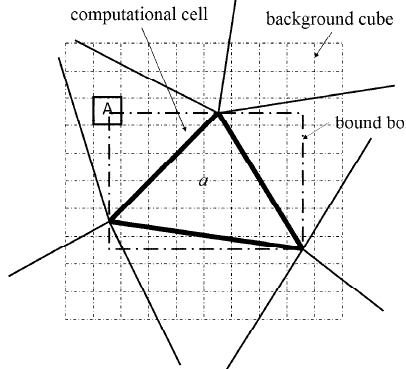
Figure 3. Overlap relation determination in existing auxiliary grid method.